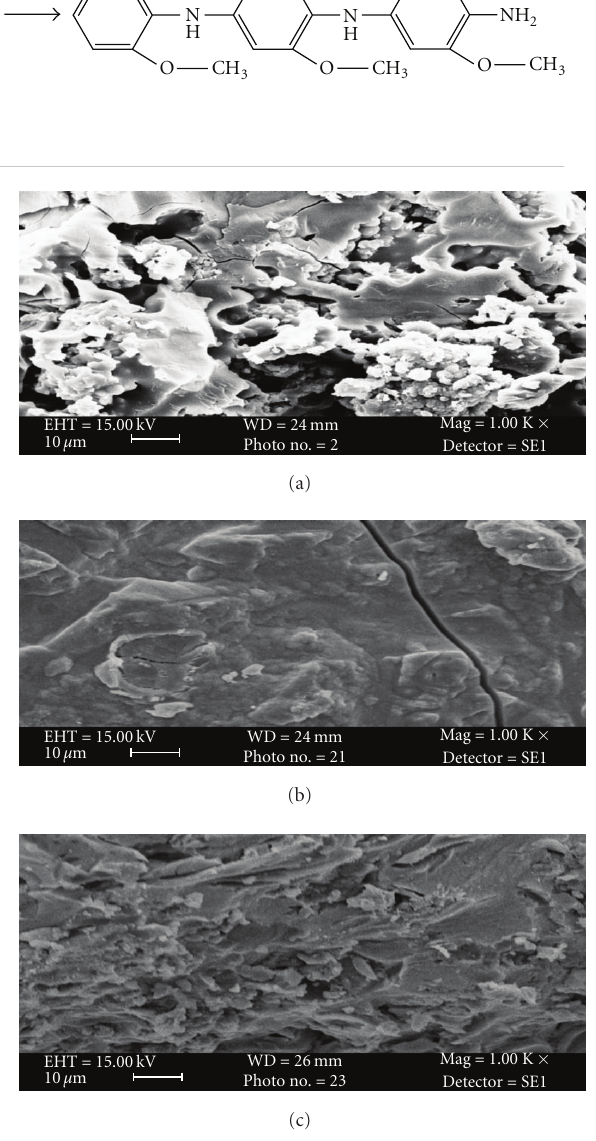
Figure 1: SEM photographs of poly-o-anisidine (a), Sn(IV) arsenophosphate (b) and poly-o-anisidine Sn(IV) arsenophosphate (c) cation exchangers.